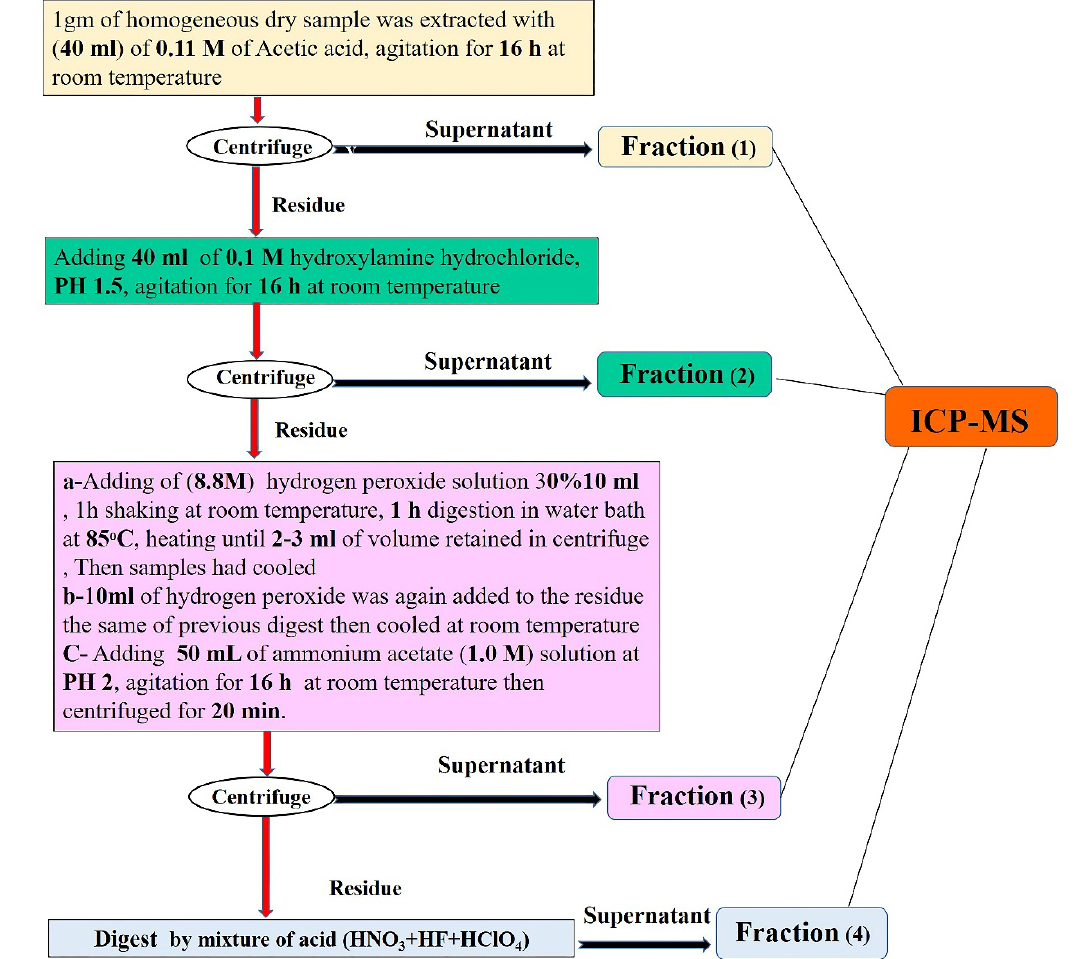
Figure 2. Flowchart of sequential extraction procedures.